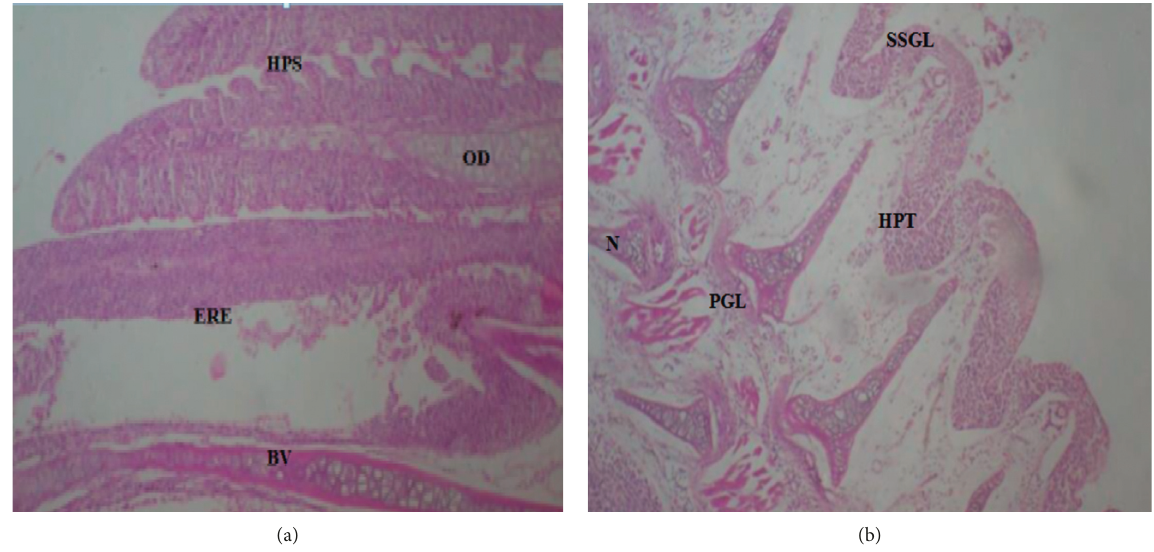
Figure 3: (a) Histological section of gill exposed to nano-CuO showing oedema of primary gill lamella (OD), epithelial hyperplasia (HPS), eroded epithelium (ERE), and the blood vessel (BV) (H&E stains, × 100). (b) Histological section of gill exposed to bulk Al 2 O 3 showing primary gill lamella (PGL), shortened secondary gill lamella (SSGL), hypertrophy (HPT), and some areas of mild necrosis (N) (H&E stains, × 400).